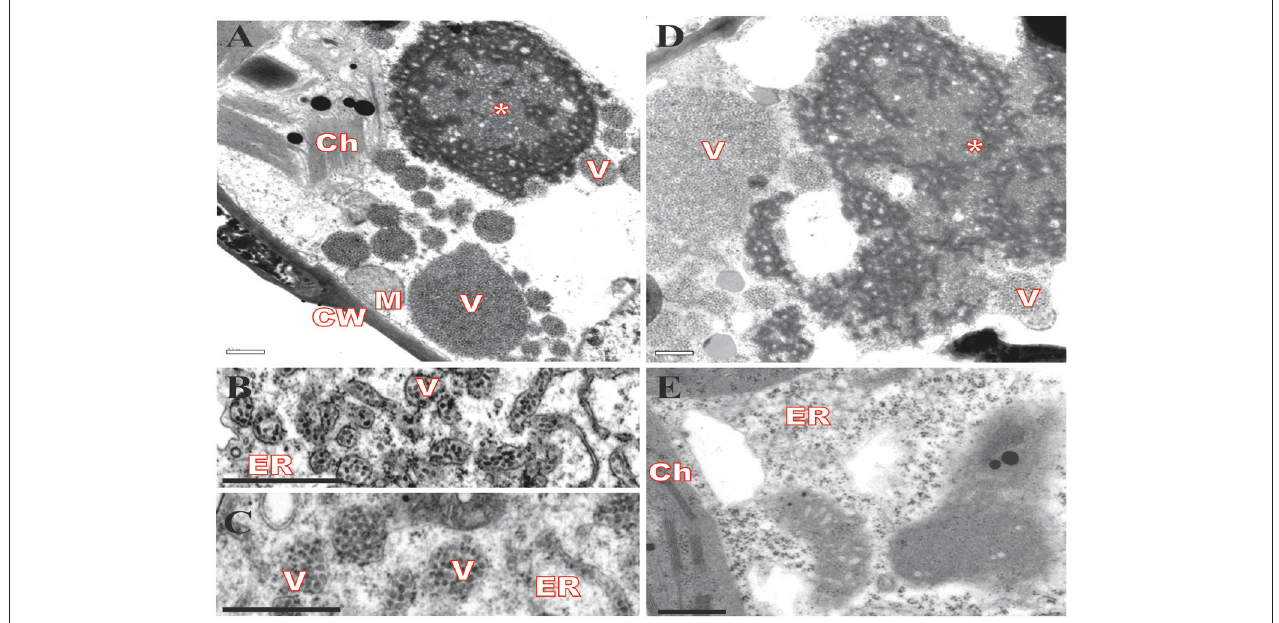
FIGURE 1 | Transmission electron micrographs from local lesion on leaves of plants experimentally inoculated by Brevipalpus yothersi viruliferous for CiLV-C shows ER membrane disorder. (A) Glycine max , (B) Abelmoschus esculentus , (C) Nicotiana clevelandii , (D) Portulaca oleracea and (E) non-infected G. max . ER membrane remodeling is observed in all infected cells, more evident in B and C , with the formation of vesicles comprising short-bacilliform (55–70nm × 100–110nm) CiLV-C particles. Characteristic electro-dense viroplasm in the ER lumen on cytoplasm is observed in A and D . Viroplasm (*), CiLV-C particle (V), Endoplasmic reticulum (ER), Cell wall (CW), Chloroplasts (Ch), and Mitochondria (M). Bars correspond to 0.5 µ